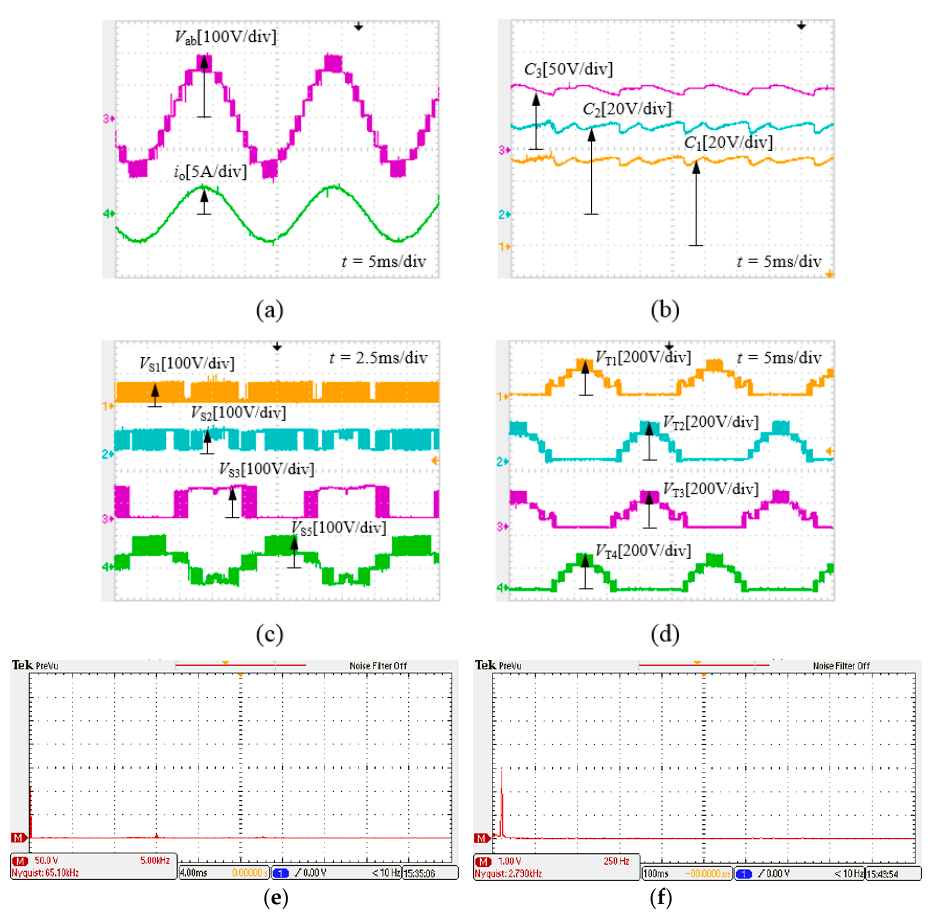
Figure 9. Experimental results of NLBI when A m = 3.4, d S 1 = 0.4 and V dc = 24 V. The waveforms from top to bottom: ( a ) Output voltage V ab , output current i o inverter; ( b ) capacitors C 3 , C 2 , C 1 voltages; ( c ) voltage of switches V S1 , V S2 , V S3 , V S5 ; ( d ) voltage of switches V T1 , V T2 , V T3 , V T4 ; ( e ) harmonic spectrum of the nine-level output voltage; and ( f ) harmonic spectrum of output current.